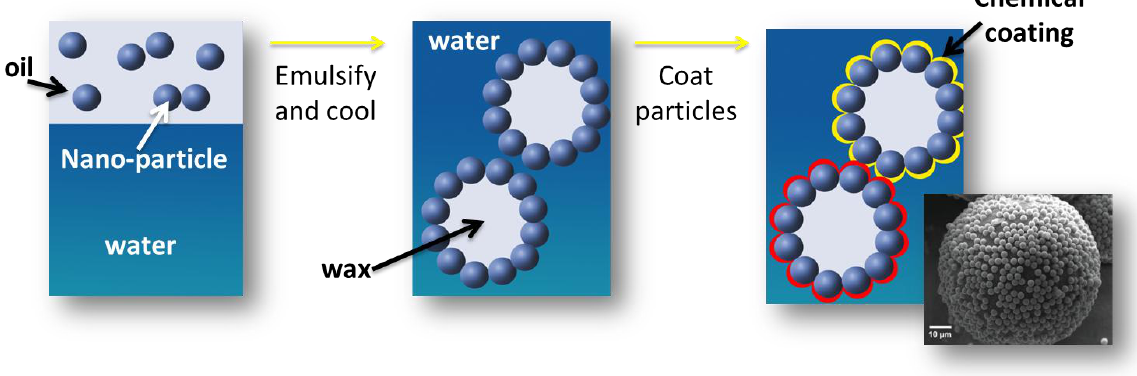
Figure 12. Schematic for manufacturing of janus nanoparticles via wax emulsion method: 1. Particles are mixed into wax, which is then emulsified with water 2. Since surface energy of particles is between that of the oil and water, they will adsorb onto the interface between the surfaces 3. Face of particles sticking out of wax can now be chemically modified [150].